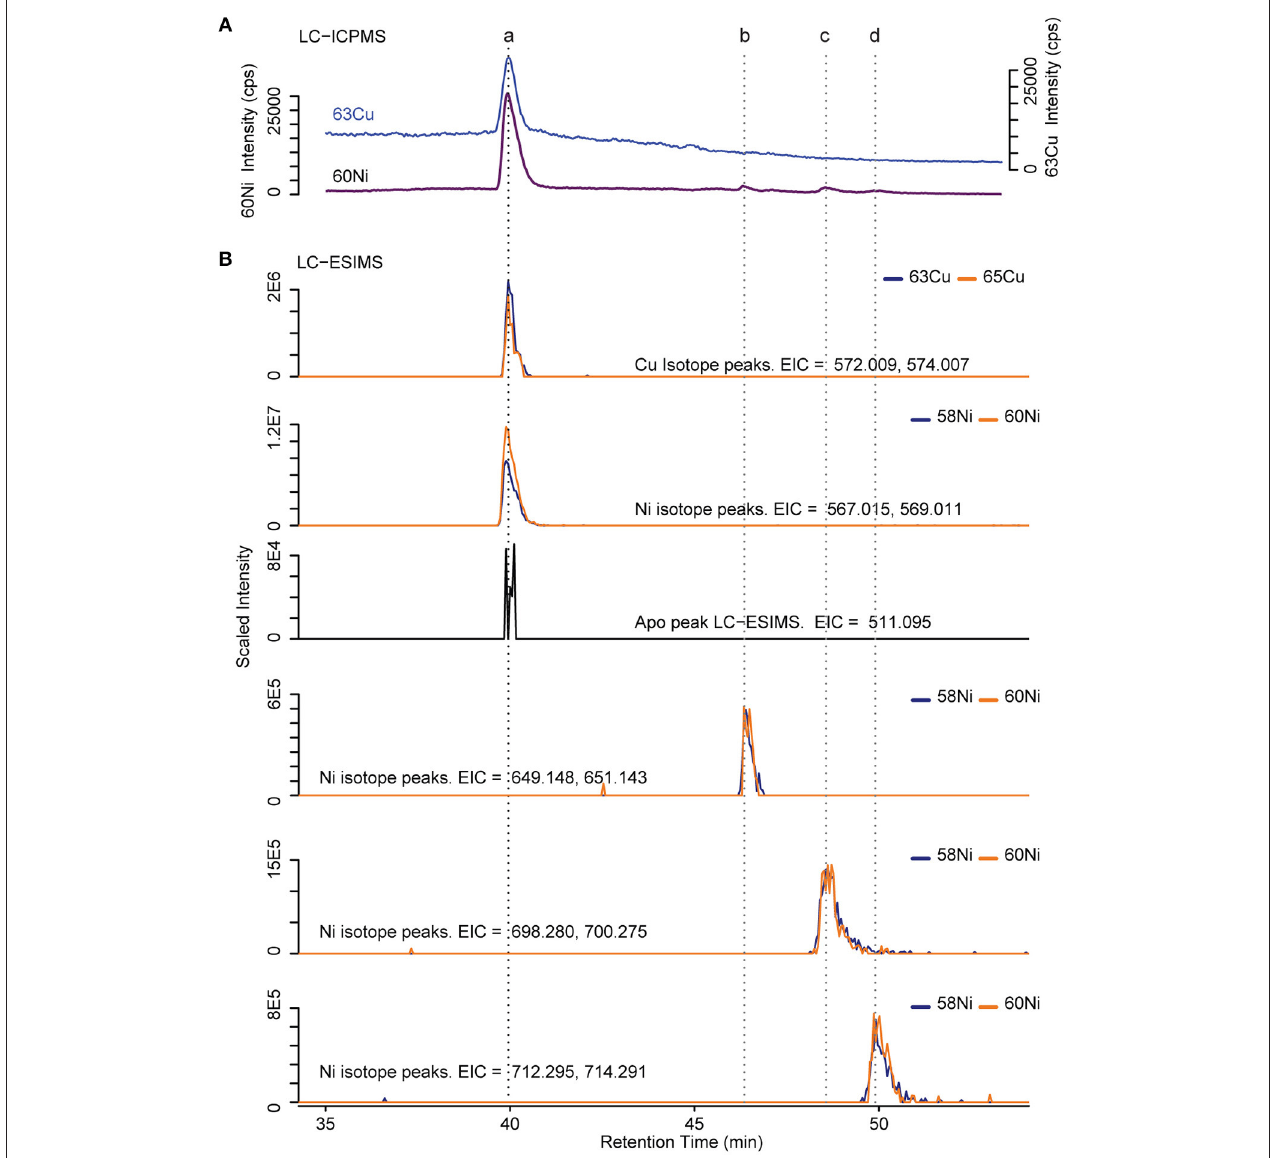
FIGURE 4 | Determination of Cu and Ni compound mass. (A) ICPMS chromatogram of 63 Cu and 60 Ni. Dashed lines indicate retention times of identified compounds (B) Extracted ion chromatograms (EIC) from positive mode ESIMS. Blue and orange lines correspond to the light and heavy metal isotopologues respectively. The intensity of the heavy isotopologue has been scaled by the natural abundance ratio of 58 Ni/ 60 Ni or 63 Cu/ 65 Cu (multiplied by 2.6 or 2.2 respectively) so that the isotopologues overlap.